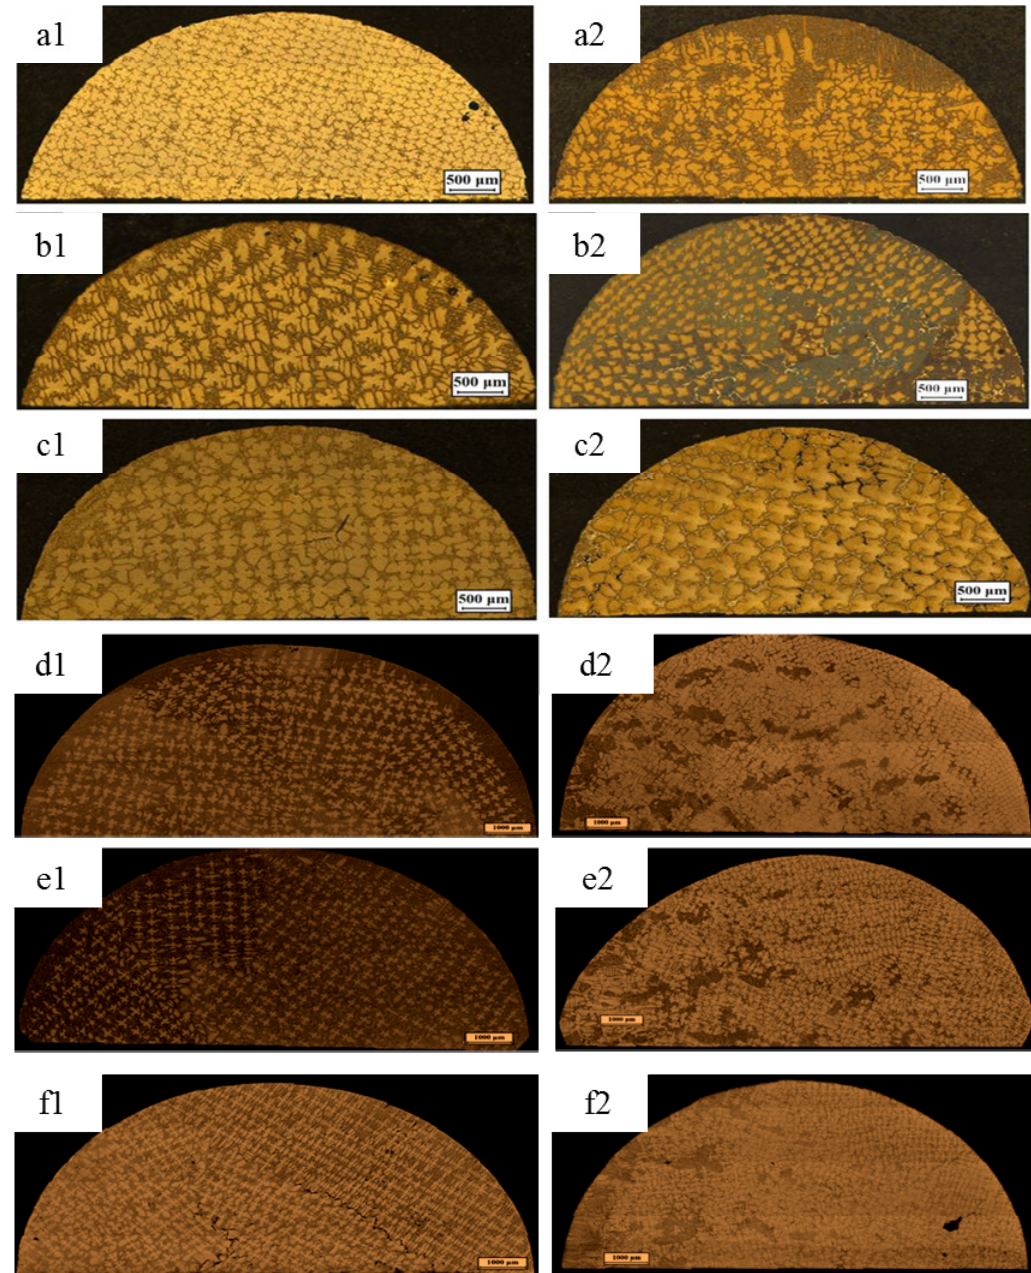
Figure 2. Transverse microstructure of directionally solidified superalloy at a temperature gradient of 80 K·cm − 1 without and with a 0.5 T transverse magnetic field (  ): ( a1 ) 0 T, 5 μ m·s − 1 , diameter of 4 mm; ( a2 ) 0.5 T, 5 μ m·s − 1 , diameter of 4 mm; ( b1 ) 0 T, 10 μ m·s − 1 , diameter of 4 mm; ( b2 ) 0.5 T, 10 μ m·s − 1 , diameter of 4 mm; ( c1 ) 0 T, 20 μ m·s − 1 , diameter of 4 mm; ( c2 ) 0.5 T, 20 μ m·s − 1 , diameter of 4 mm; ( d1 ) 0 T, 5 μ m·s − 1 , diameter of 12 mm; ( d2 ) 0.5 T, 5 μ m·s − 1 , diameter of 12 mm; ( e1 ) 0 T, 10 μ m·s − 1 , diameter of 12 mm; ( e2 ) 0.5 T, 10 μ m·s − 1 , diameter of 12 mm; ( f1 ) 0 T, 20 μ m·s − 1 , diameter of 12 mm; (f2) 0.5 T, 20 μ m·s − 1 , diameter of 12